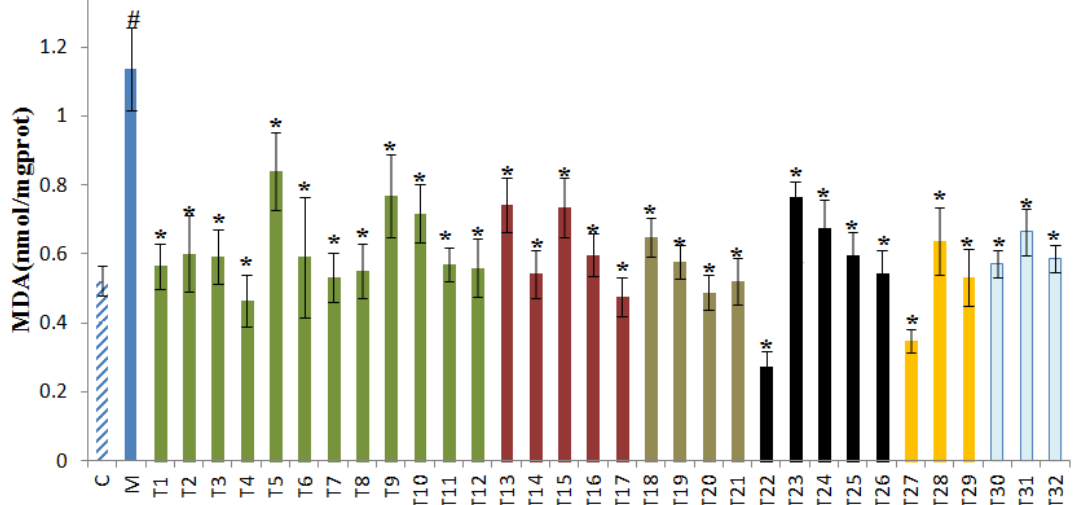
Figure 4. The effects of 32 teas on liver malondialdehyde (MDA) level. # p < 0.05, the model group versus the control group. * p < 0.05, the treatment group versus the model group. C, the control group; M, the model group. T1, Chaoqing Green Tea; T2, selenium-enriched Chaoqing Green Tea; T3, Enshi